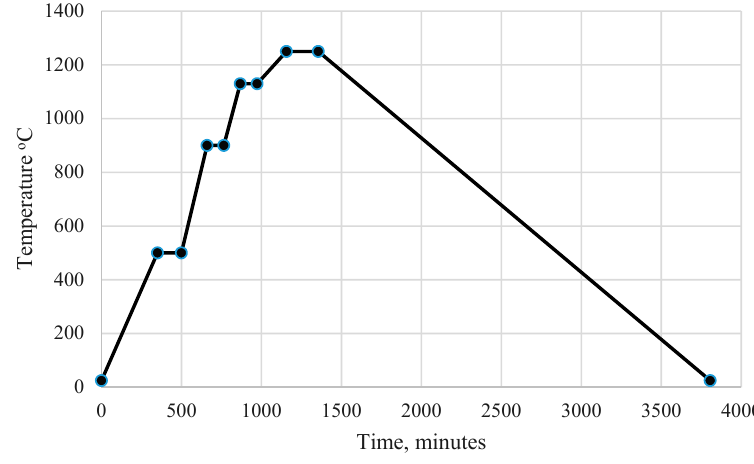
Figure 6. Combined cycle for thermal de-binding and sintering of MIM brown parts.